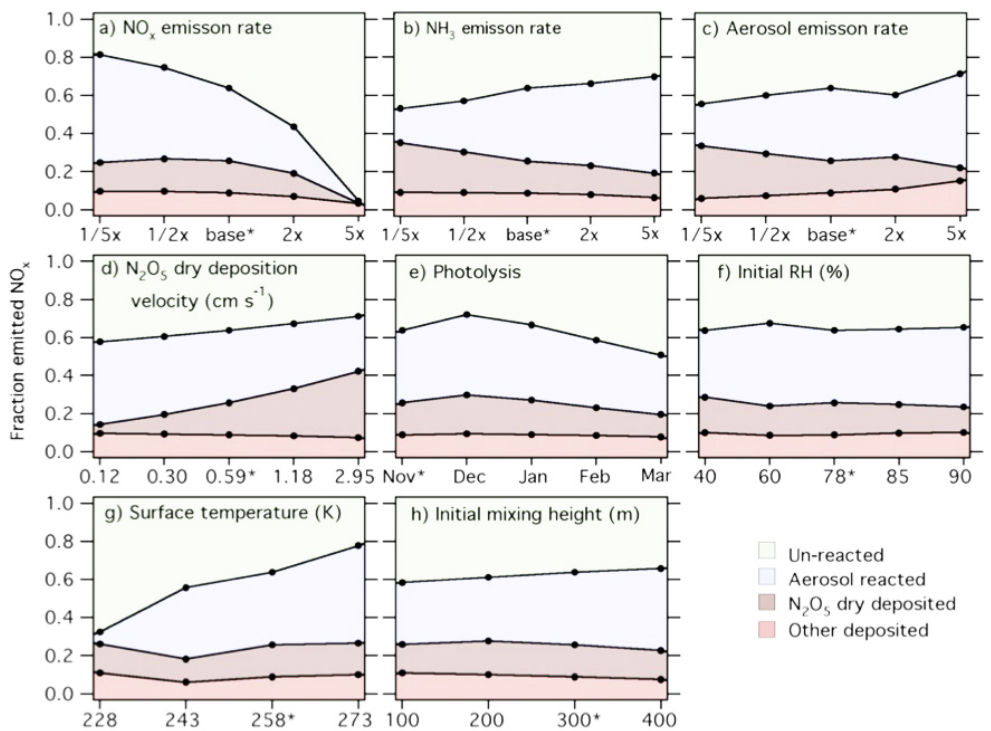
Figure 6. Sensitivity of the fate of emitted NO x to model parameters was investigated by variations of constraints on the base case. Shown are speciation fractions of total column nitrogen emitted as NO x at t = 50h, corresponding to 2 days after the emission period begins. Base case runs are marked by an asterisk ( ∗ ).